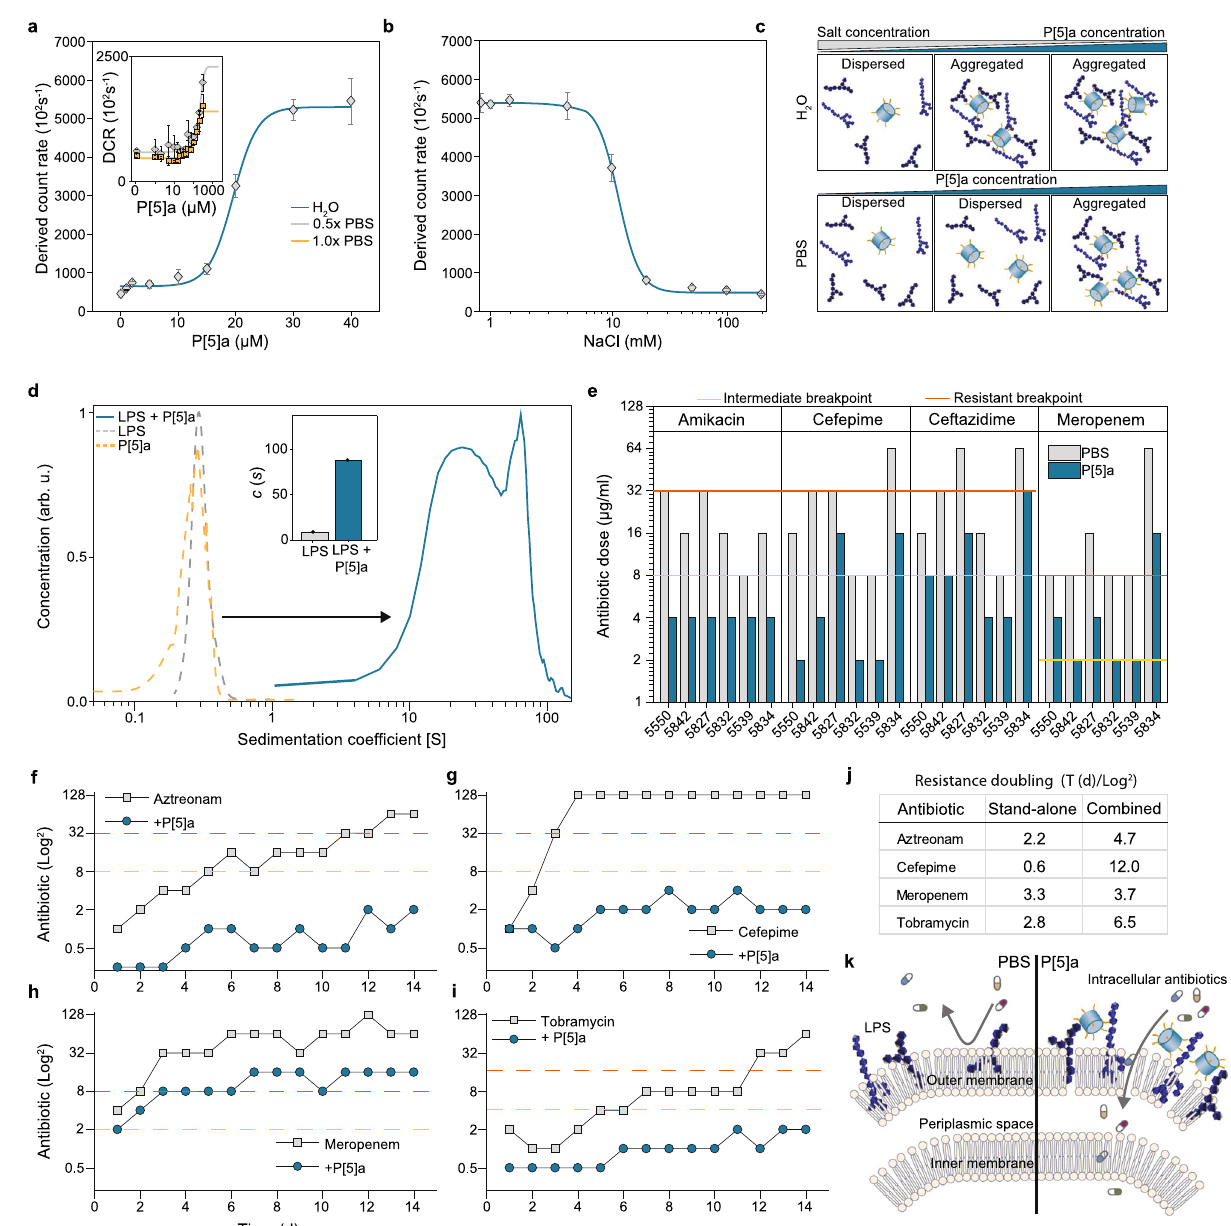
Fig.4 |P[5]ainteractswithLPSinthebacterialOM,enhancingthepenetration and potency ofco-administeredantibiotics.a P[5]a titratedinto 0.1mg/ml PA10 LPS(5-10 µ M)solutioninwaterwithDLSshowstheformationandassemblyoflarge complexes starting at 15 µ M of P[5]a.The data represent averagevalues ± s.d ( n =3 independent experiments per group).Expansionhighlightsthe formation of P[5]a- LPS complexes in 0.5x and 1x physiological conditions. b The interaction and aggregation observedin( a ) is reversible by the addition ofsalt (NaCl),which leads tothedissociationofthelargercomplexes.Thedatarepresentaveragevalues±s.d ( n =3independentexperimentspergroup). c SchematicrepresentationoftheNaCl effectsonthecomplexationofP[5]a-LPS. d Analyticalultracentrifugationshowsthe sedimentation coef fi cient of P[5]a alone on the left at 60,000rpm and P[5]a with LPS of PA10 on the right at 25,000rpm, revealing the presence of high-molecular weight structures, up to 1×10 6 Da. Expansion highlights that a majority of the LPS, 91%,ispresentinthelargerP[5]a-LPScomplexes( n =1independentexperimentper group). e P[5]a enhances the ef fi cacy of co-administered antibiotics amikacin,